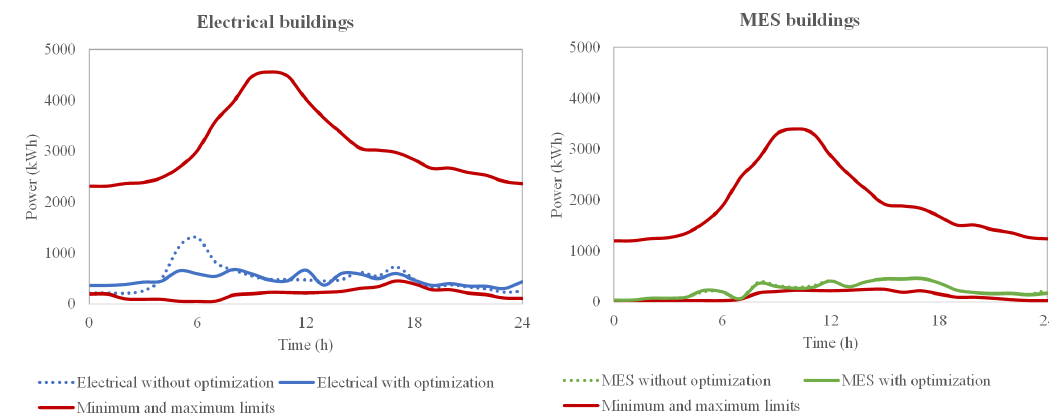
Figure 12. Total flexibility offered by electrical and MES